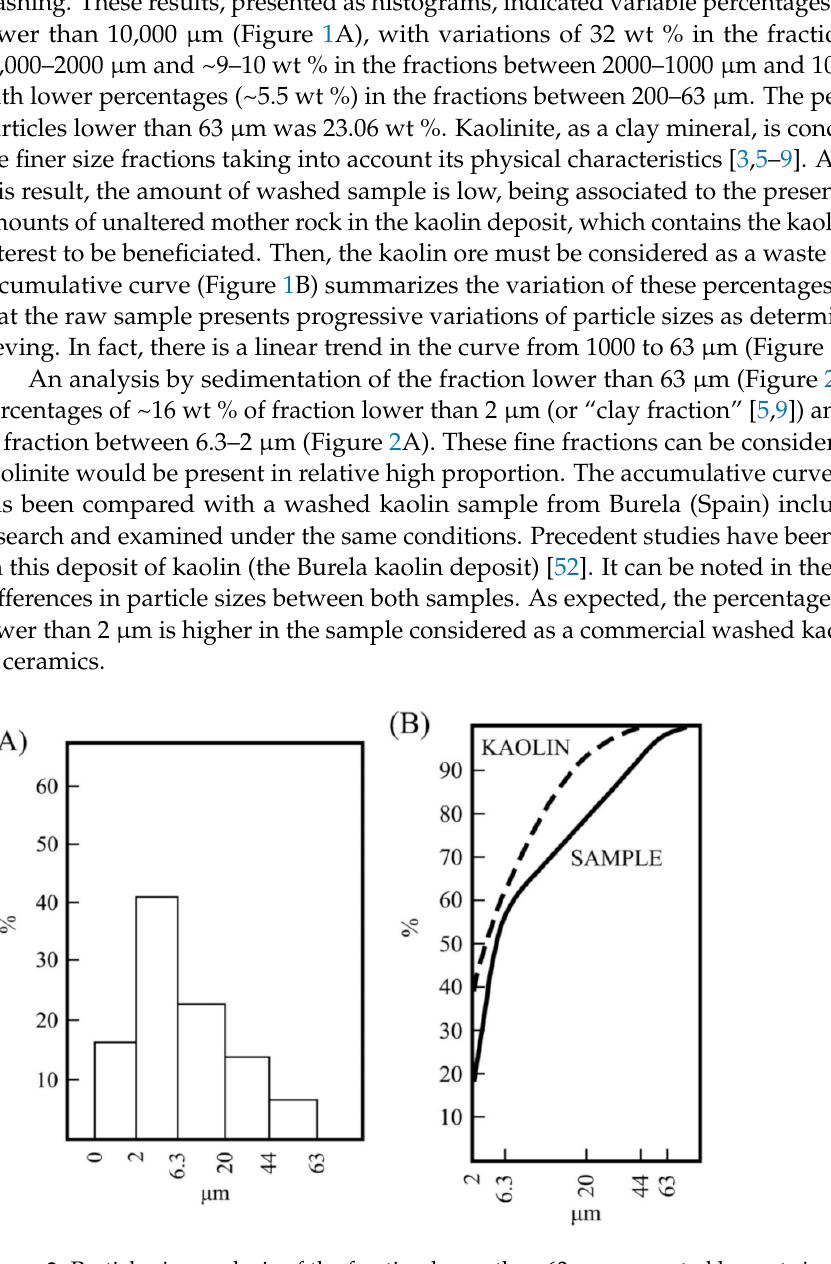
Figure 2. Particle size analysis of the fraction lower than 63 µ m separated by wet sieving from the raw kaolin sample: ( A ) histogram of the obtained fractions and ( B ) curve of particle size distribution (labelled as SAMPLE) obtained from the above results. A washed sample of kaolin of Burela was analysed under the same experimental conditions (see the text) and the experimental curve is included (labelled as